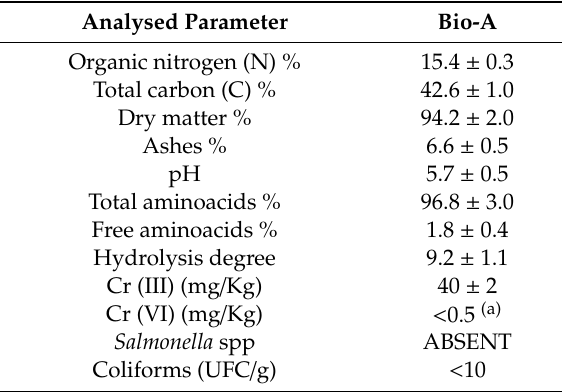
Table 1. Hydrolysed biomass analysis was subjected to elemental analysis with titration to determine free amino acid content (Table 2) and microbiological tests for bacterial contaminants. Table 1. Elemental analysis of Bio-A.